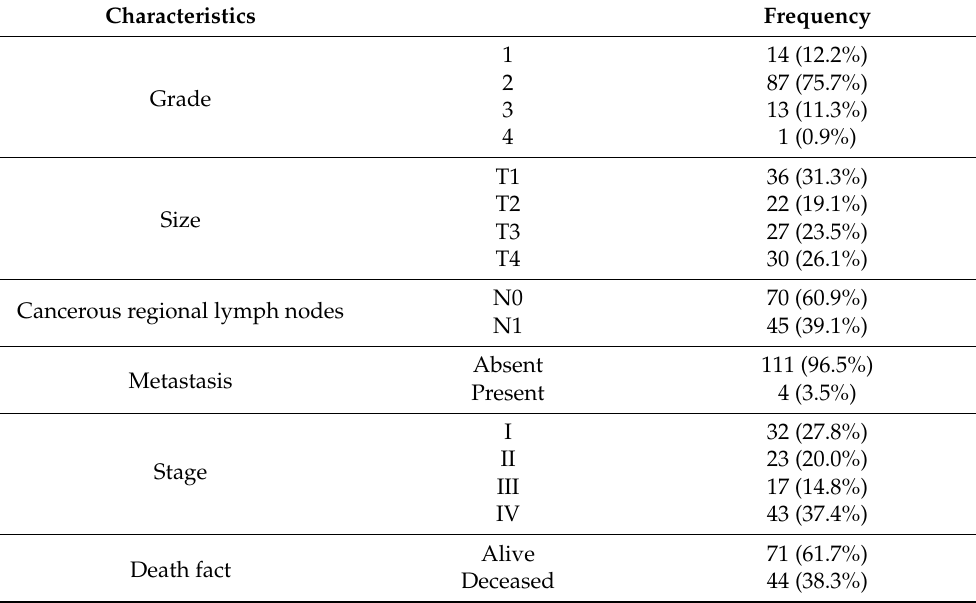
Table 2. The distribution of tumor and clinical